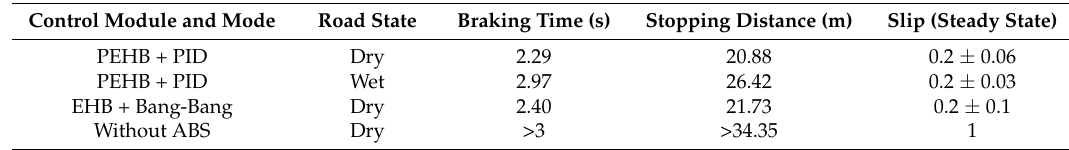
Table 4. A summary of the parameters of each